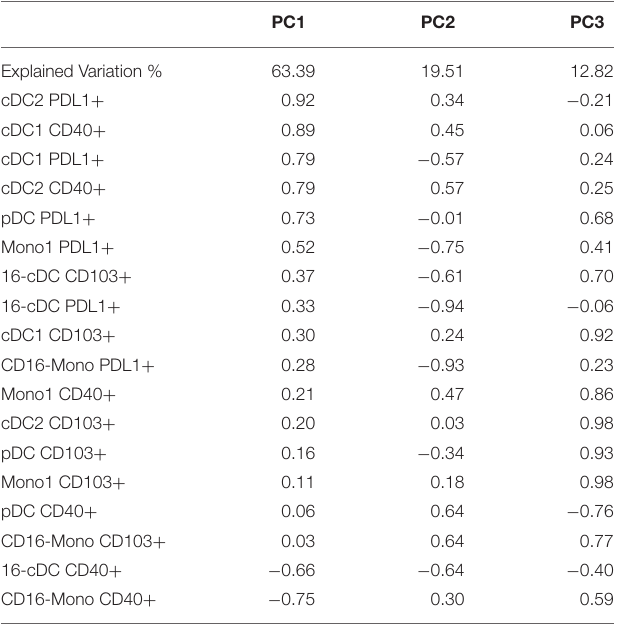
TABLE 3 | Loadings from principal component analysis of activated